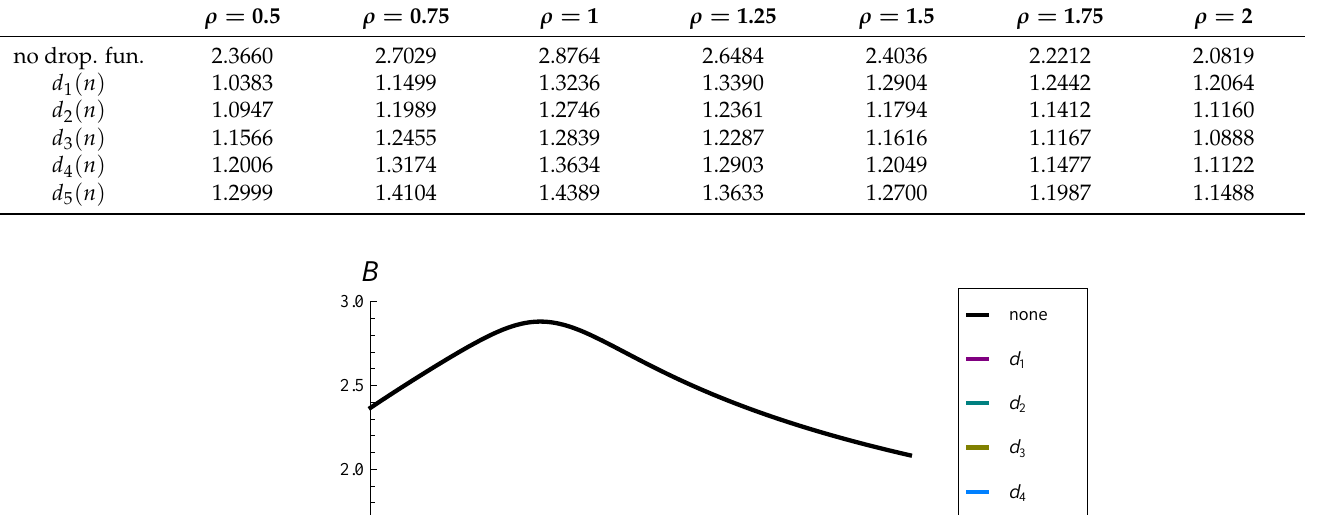
Table 3. Burst ratio for selected values of the system’s load.